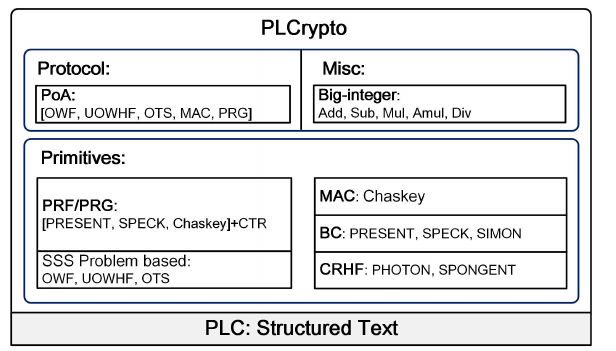
Figure 1: Overview of PLCrypto